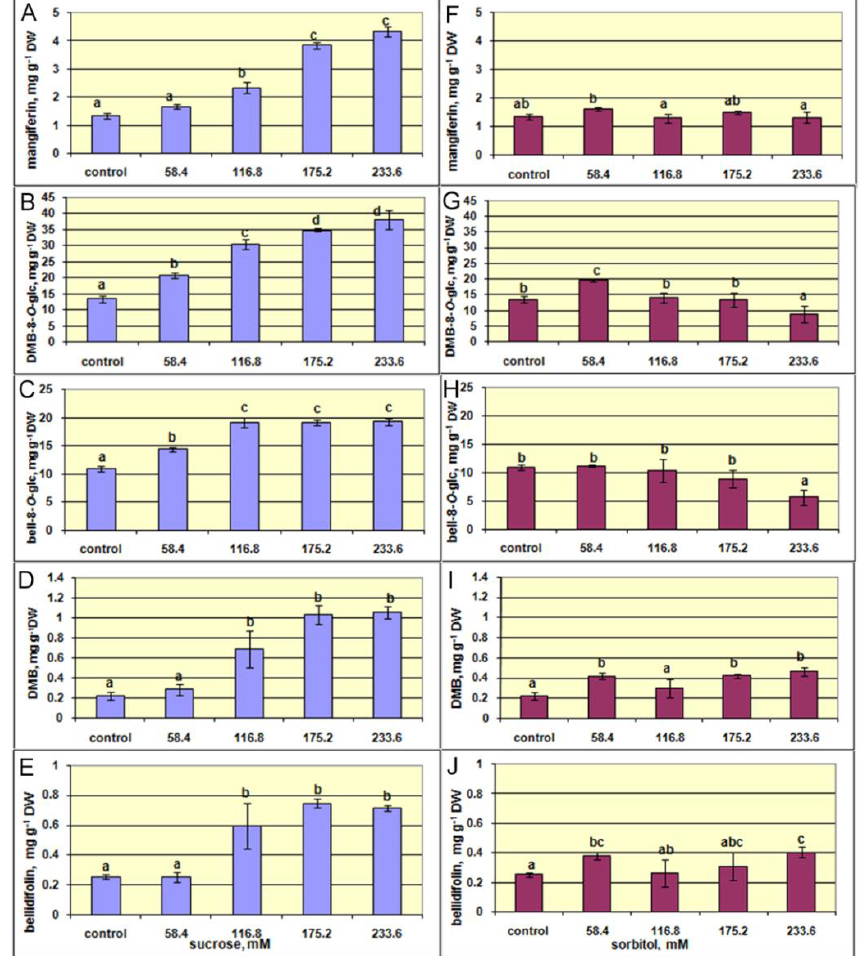
Figure 8. The effect of increasing concentrations (58.4, 161.8, 175.2, and 233.6 mM) of sucrose ( A – E ) and sorbitol ( F – J ) on the content of xanthones mangiferin, demethylbellidifolin-8- O -glucoside (DMB-8- O -glc), bellidifolin-8- O -glucoside (bell-8- O -glc), demethylbellidifolin (DMB) and bellidifolin in shoots cultures of G. lutescens (line 5) after 35 days of culture. The increasing concentrations of sucrose or sorbitol were added into control medium (BM + 0.2 mg L −1 BA containing 58.4 mM sucrose). Values are the means ± SE of four to eleven biological replicates ( n = 4 – 11). Values denoted by the same letter are not significantly different according to the Fisher’s LSD test at p ≤ 0.05 following one-way ANOVA.